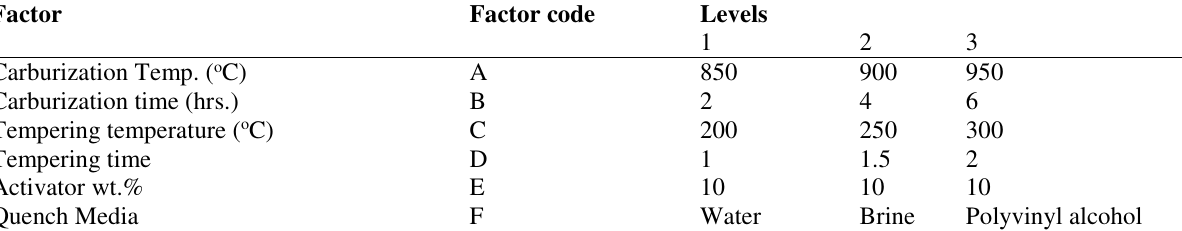
Factors and their levels of carburization. Factor Factor code Levels Carburization Temp. ( o C) Carburization time (hrs.)